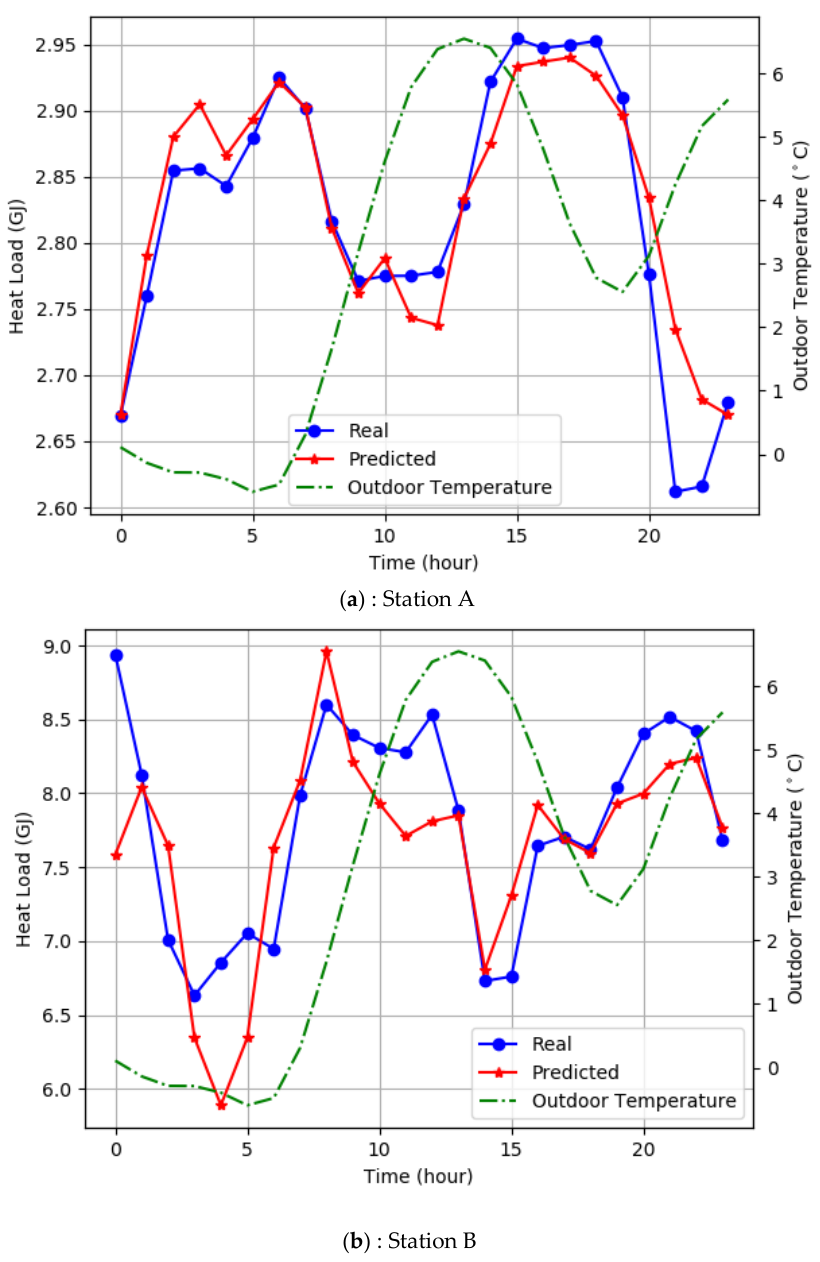
Figure 8. The prediction result curves for the next 24 h for ( a ) station A and ( b ) station B.